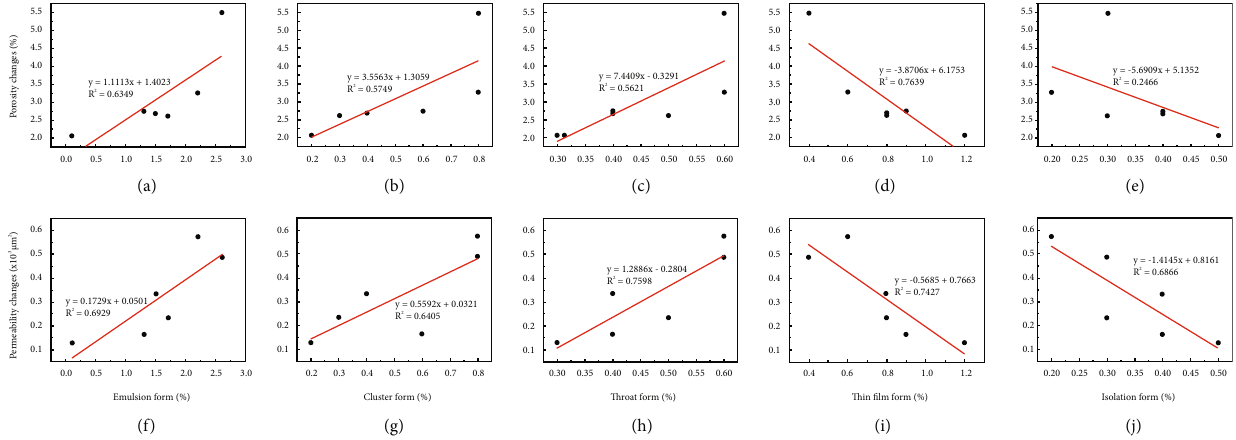
Figure 8: The relationship between adsorption tight oil types and the change of porosity permeability before and after Soxhlet extraction. (a – e) The relationship of emulsion form, cluster form, throat form, thin fi lm form, and isolation form with the change of porosity before and after Soxhlet extraction; (f – j) the relationship of emulsion form, cluster form, throat form, thin fi lm form, and isolation form with the change of permeability before and after Soxhlet